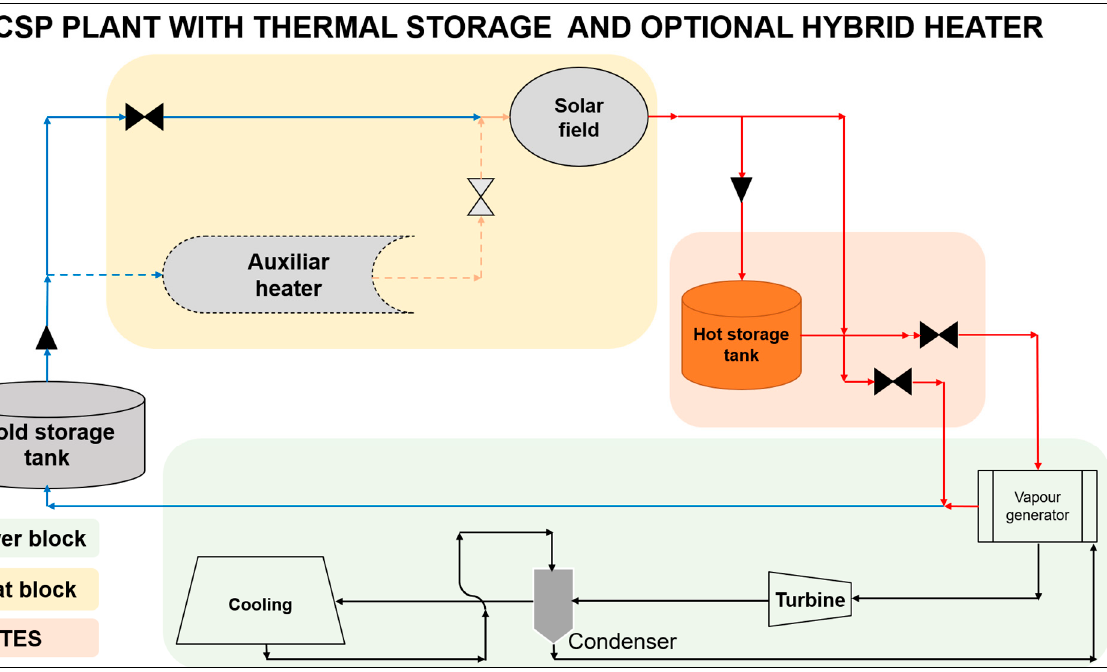
Figure 7. Plant schematics with auxiliary heating system (represented by